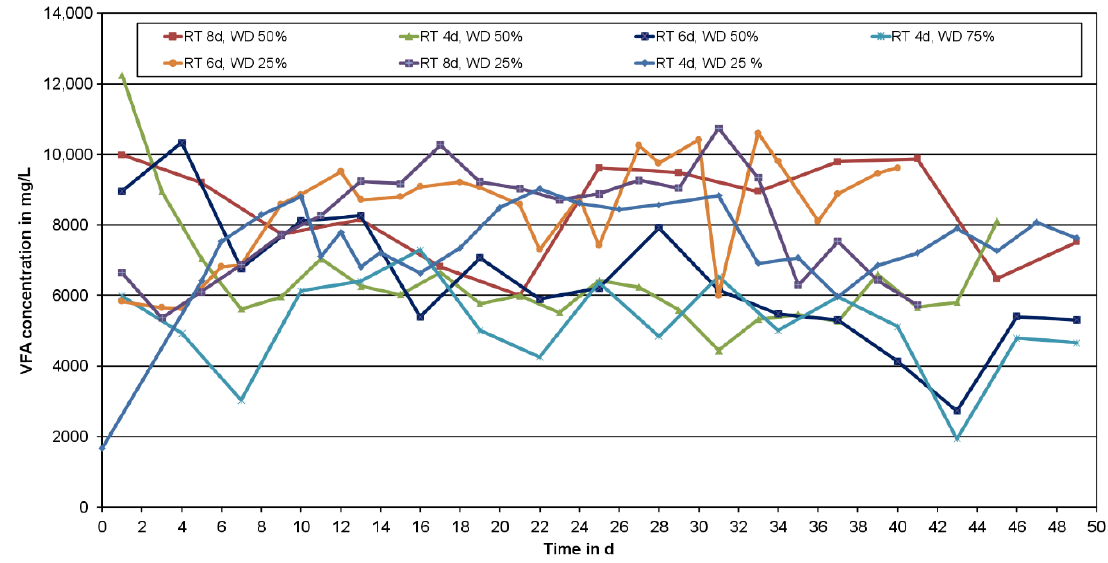
Figure 5. VFA concentration in dependence of RT and WD.